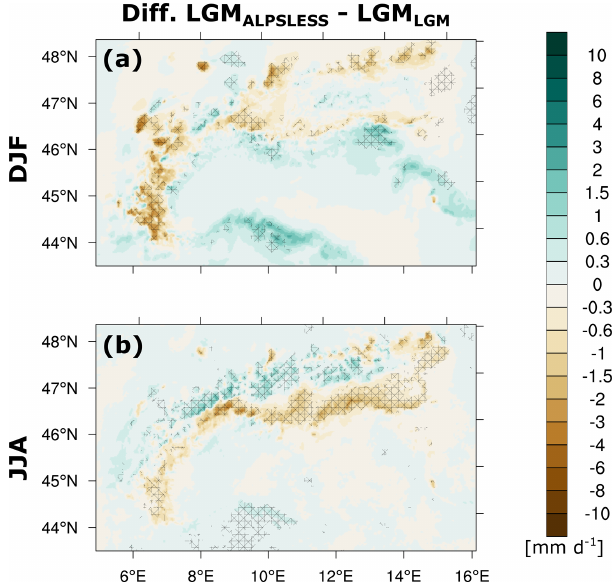
Figure 10. Differences in climatological mean values of daily precipitation intensity over the Alps between LGM ALPSLESS and LGM LGM for (a) winter (DJF) and (b) summer (JJA). Crosshatched areas indicate statistically significant differences at a significance level of 0.05 (using a two-tailed bootstrapping technique).